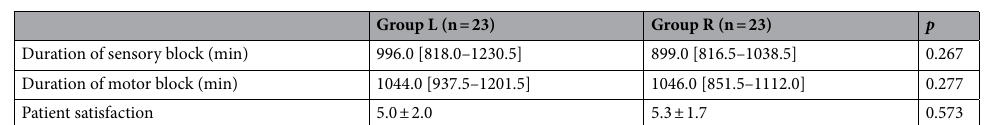
Table 4. Block duration and patient satisfaction. Data are presented as mean ± standard deviation or median [interquartile